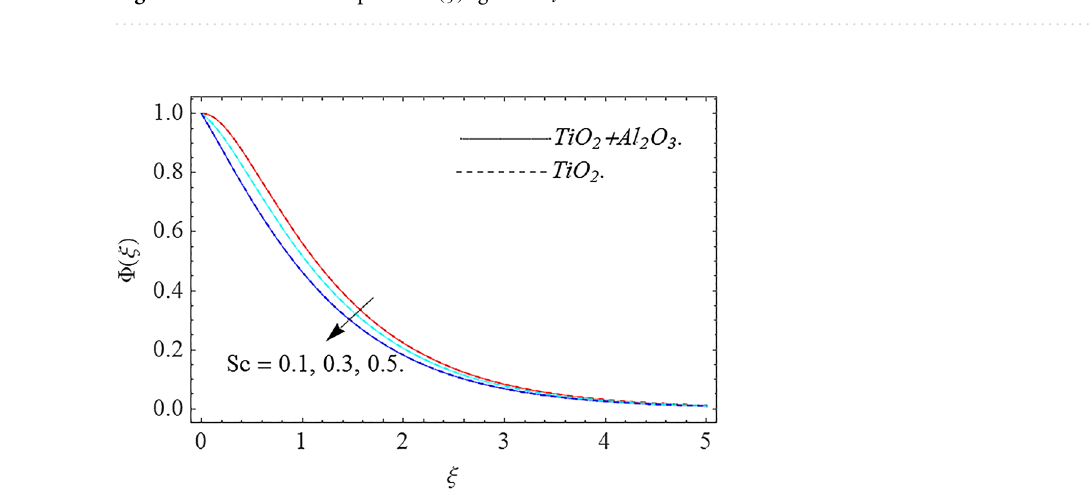
Figure 15. Concentration profile �(ξ) against Sc